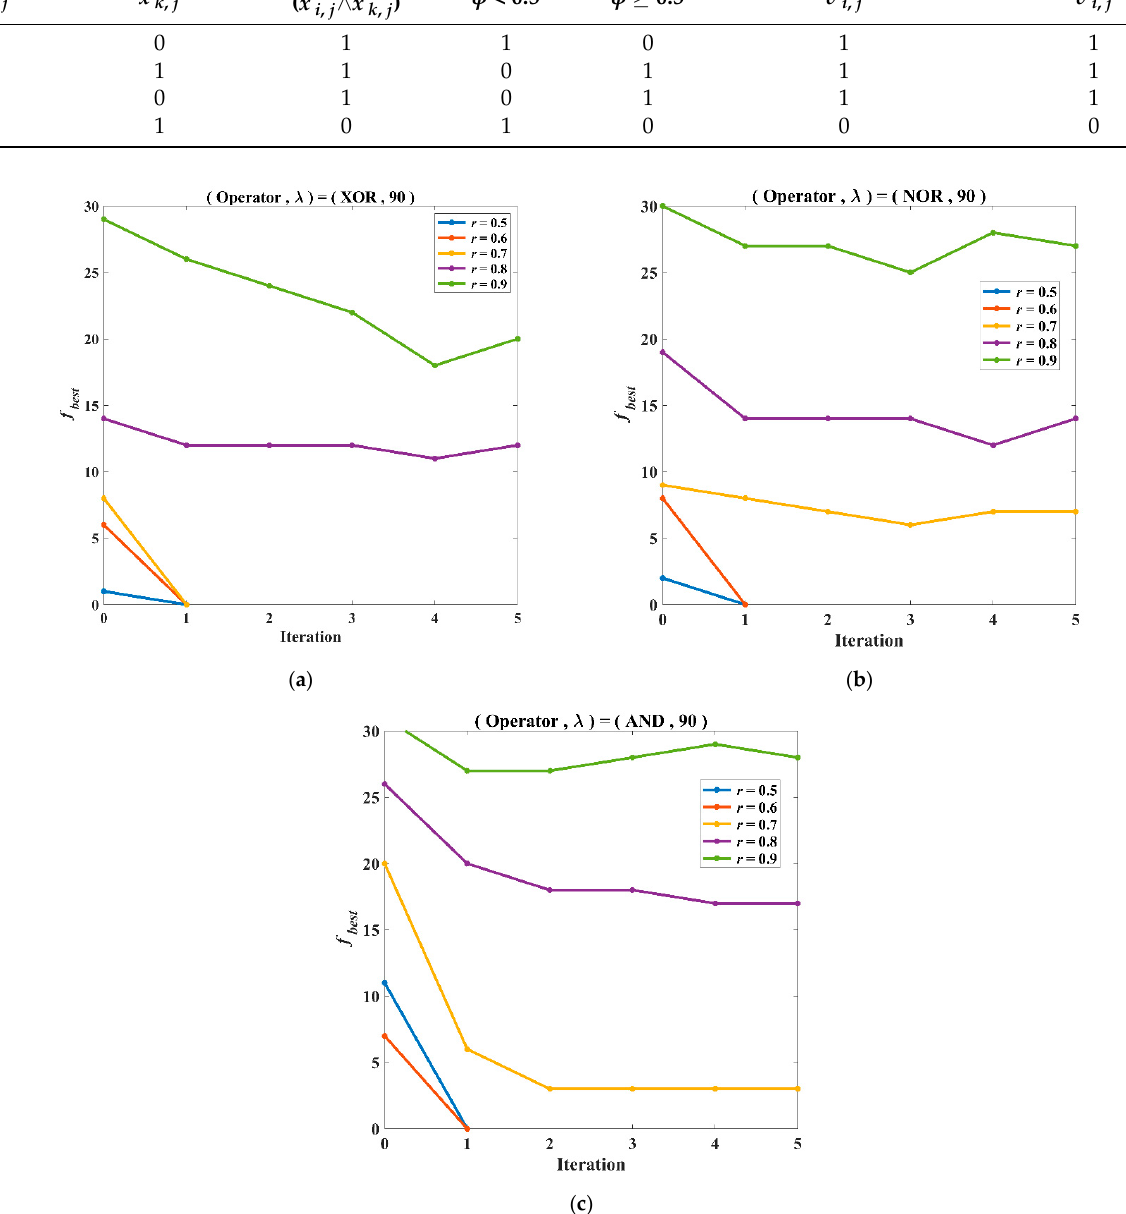
Figure 4. ( a ) best f for − 2SAT xor ABC r ; ( b ) best f for − 2SAT nor ABC r ; and ( c ) best f for Figure 4. ( a ) f best for r 2SAT xor − ABC ; ( b ) f best for r 2SAT nor − ABC ; and ( c ) f best for r 2SAT and − ABC − 2SAT and ABC r .